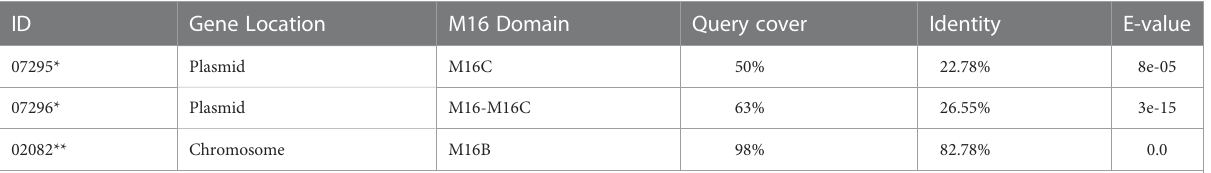
TABLE 2 Blast analysis of M16 domains identi fi ed in ORY1 against reference sequences. E-value corresponds the number of expected hits of similar quality (score) that could be found just by chance.